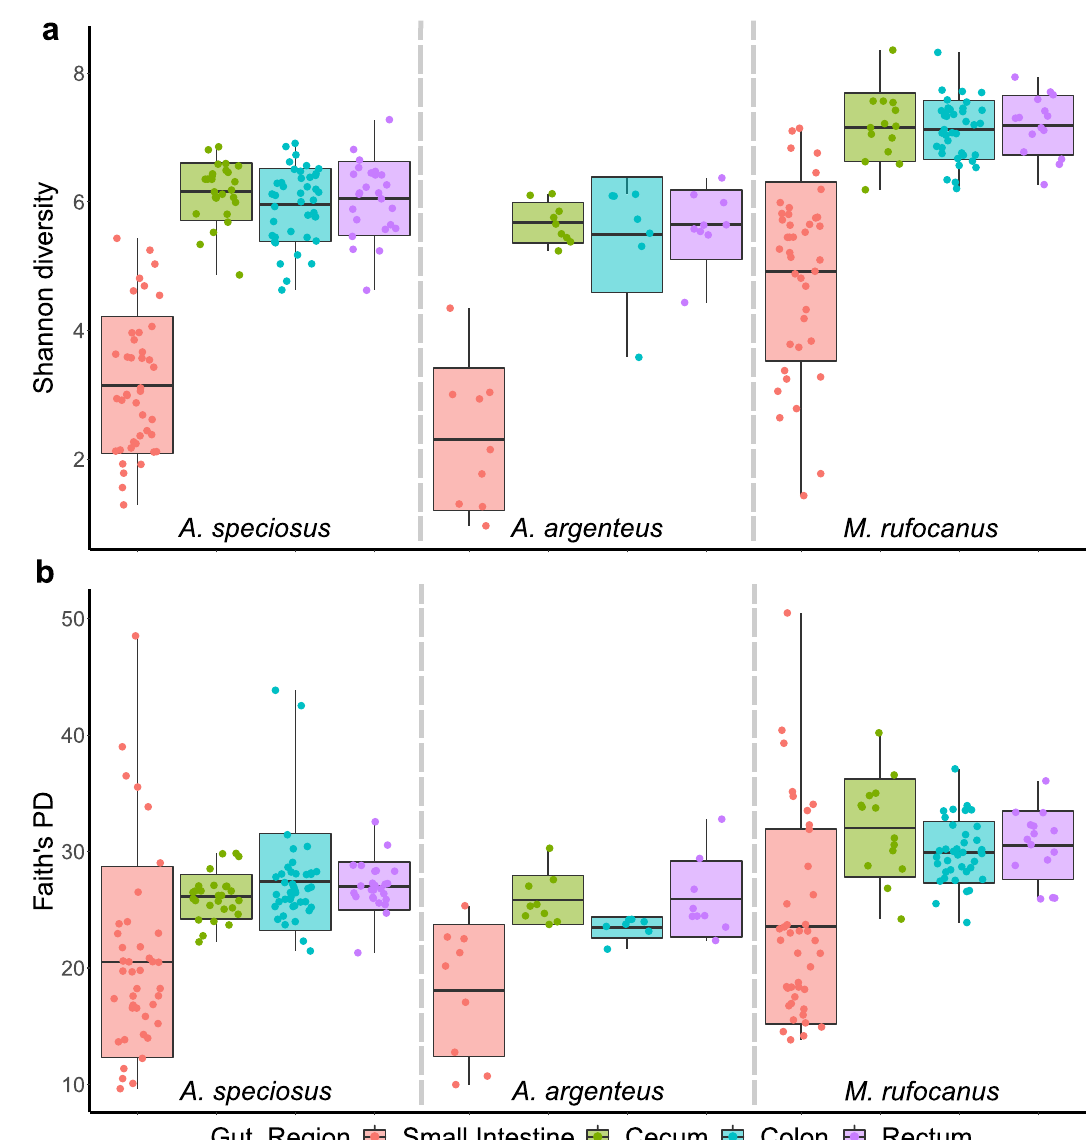
Figure 1. Alpha diversity within each gut region of each species based on ( a ) Shannon diversity and ( b ) Faith’s PD. Dashed lines separate host